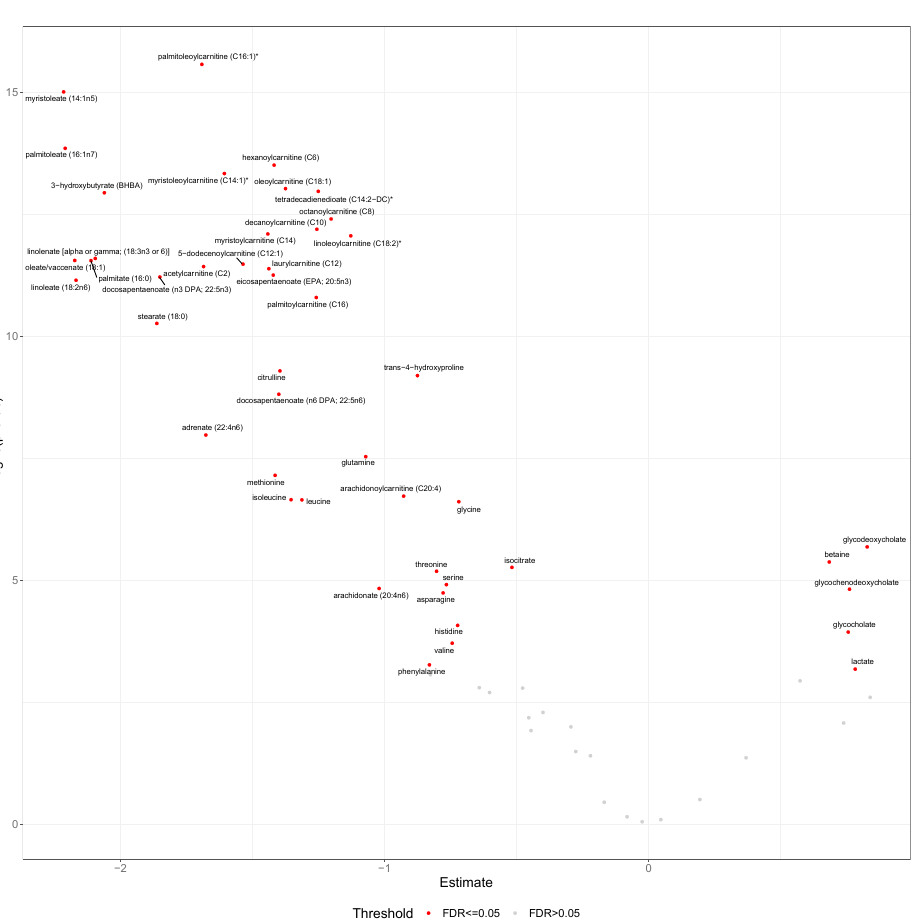
Figure 2. Mean ∆ fast-120 min for metabolites at early pregnancy. This volcano plot displays mean ∆ fast-120 min post-OGTT and -log 10 P values for all candidate metabolites (n = 65) among PEARLS participants at the baseline visit ( n = 29). Metabolites labeled with red passed the false discovery rate threshold of p < 0.05. Abbreviations: FDR, false discovery rate; OGTT, oral glucose tolerance test; PEARLS, Pregnancy and EARly Lifestyle improvement Study; ∆ fast-120 min, changing in glucose from fasting to 120 min during the OGTT.